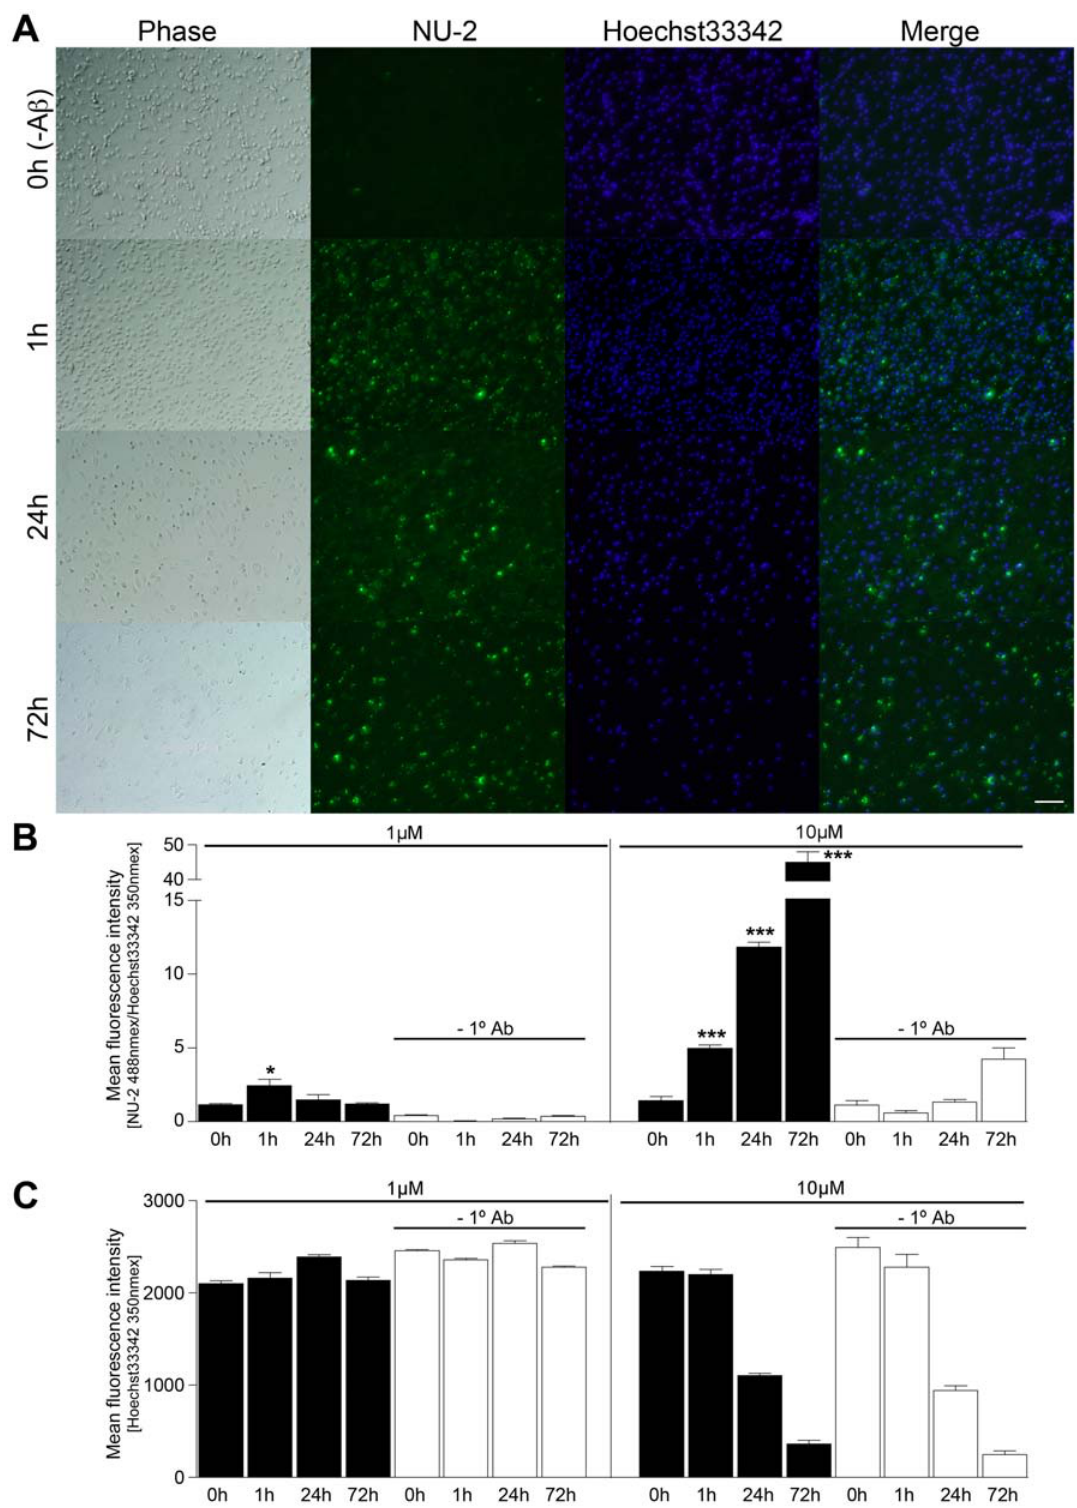
Figure 5. A b aggregation in mouse primary microglia. Mouse primary microglia (5 6 10 4 per well) were seeded in 96-well tissue culture plates, and incubated with monomeric A b 42 (1 or 10 m M) in phenol red-free DMEM for 0 (-A b ), 1, 24, and 72 h, followed by washing, fixation, and immunocytochemistry with NU-2 anti-A b oligomer antibody (green) and Hoechst 33342 for nuclear staining (blue). (A) Representative phase and merged immunofluorescet images after incubation with 10 m M A b 42. Scale bar, 100 m m. (B, C) Fluorescent intensity of A b (B) or nuclear (C) signals were quantified using fluorometer (Ex/Em 488 nm/519 nm for Alexa 488, and 350 nm/461 nm for Hoechst 33342, respectively, n=3 per group). 2 1 u Ab represents negative control staining of microglia for A b (B) or nuclear (C) staining using secondary antibody (Alexa 488 anti-mouse IgG) and Hoeschst 33342 for nuclear staining. * or *** denotes p , 0.05 or 0.001 versus 0 h incubation, respectively.